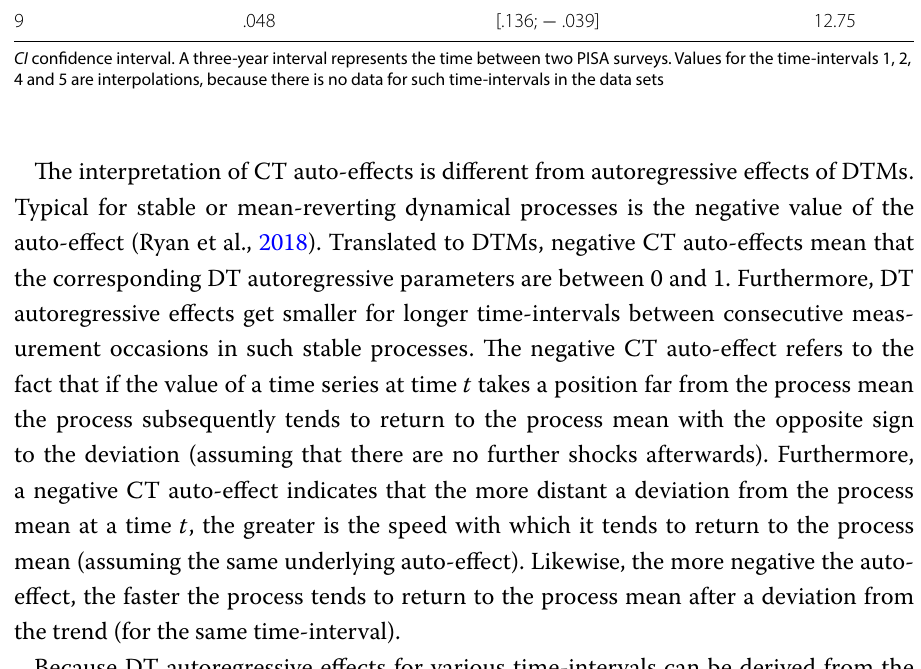
CI confidence interval. A three‑year interval represents the time between two PISA surveys. Values for the time‑intervals 1, 2, 4 and 5 are interpolations, because there is no data for such time‑intervals in the data sets